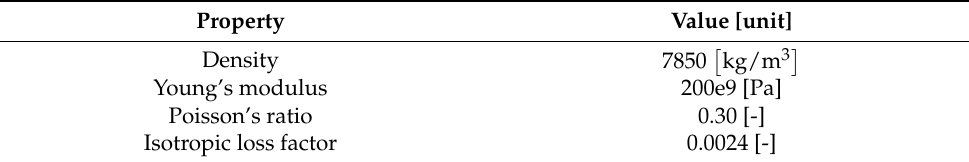
Table 1. Material properties of structural steel.